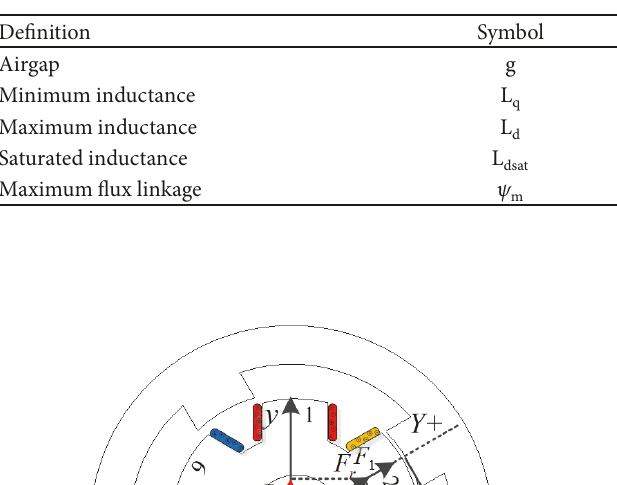
Table 1: The SRM parameter values.